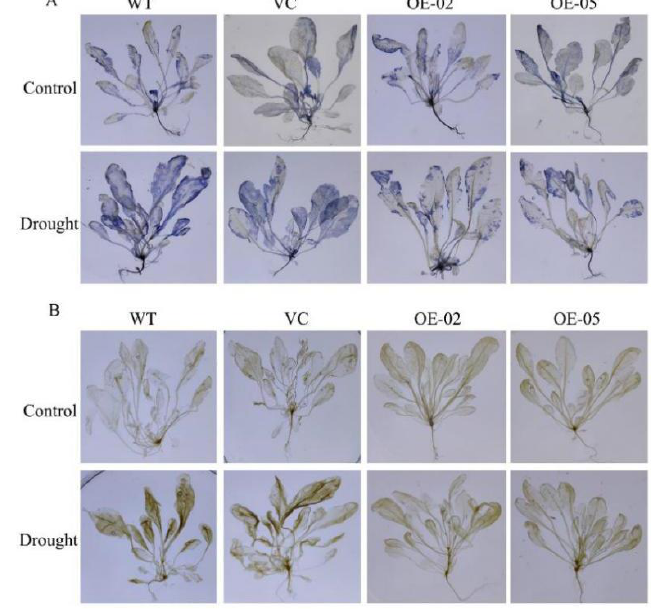
Figure 8. Changes in O 2 − and H 2 O 2 levels in wild-type (WT) and transgenic plants subjected to drought stress. Drought-stressed seedlings were incubated in nitroblue tetrazolium (NBT) or diaminobenzidine (DAB) solution. Blue staining indicates O 2 − accumulation ( A ). Brown staining indicates H 2 O 2 accumulation ( B ). Control, plants growing under normal conditions; drought, plants growing after drought stress treatment (12 days).